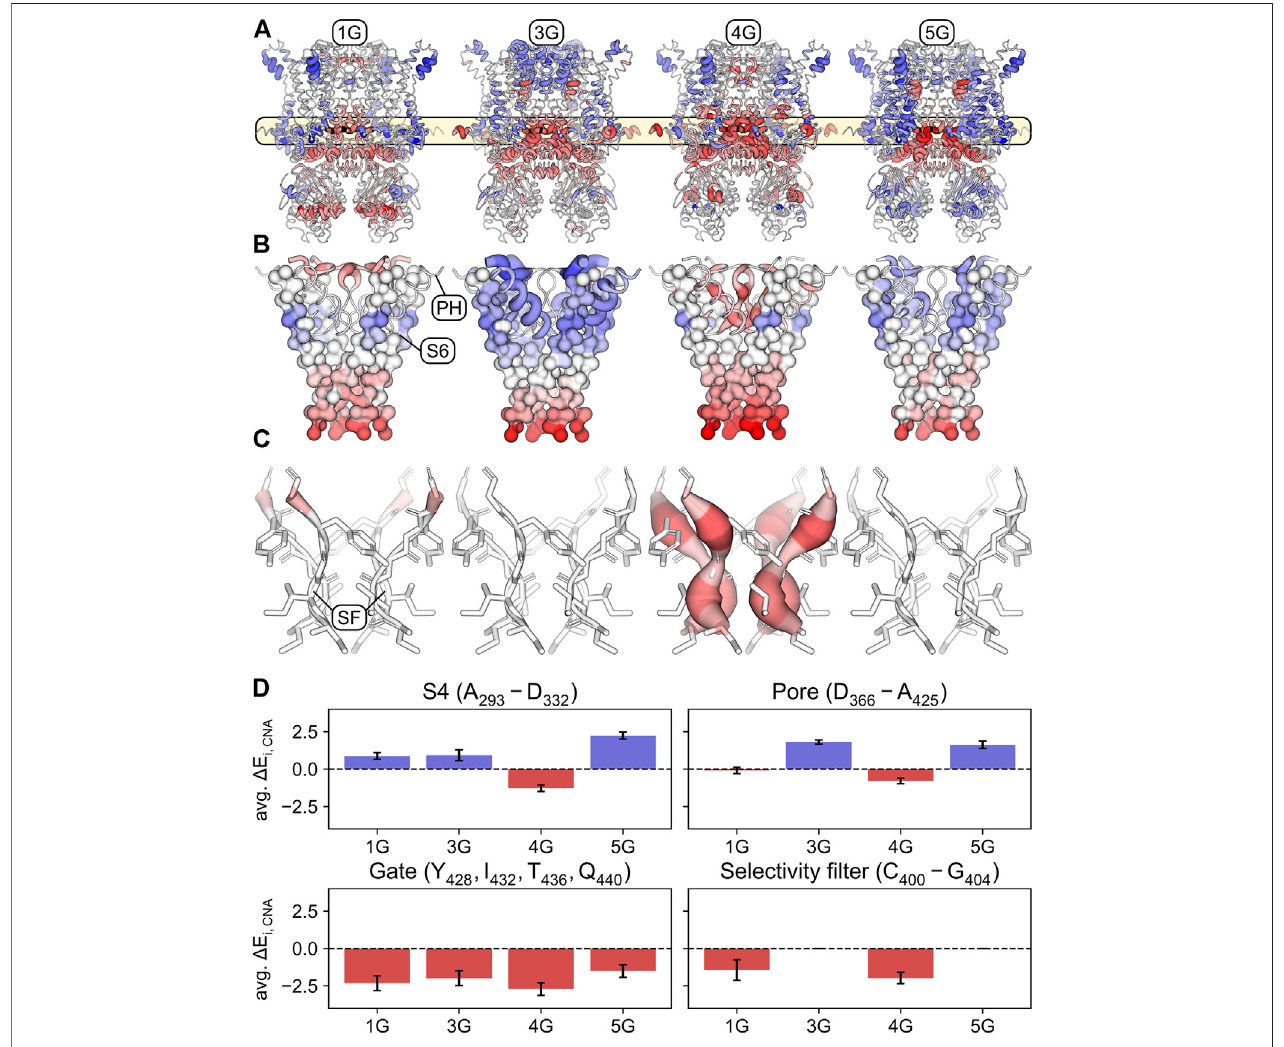
FIGURE 6 | Stabilized and destabilized regions of the glycine-linker constructs according to rigidity analyses. (A) Mapping of the differences Δ E i ,CNA = E i ,CNA(0G) − E i ,CNA( n G) – averagedacrosssimulationsandsubunits – ontothestructureofthewildtypechannel(0G).Regionsthataresigni fi cantlystabilizedintherespectiveconstruct compared to 0G (positive Δ E i ,CNA values) are shown in shades of blue. Regions that are signi fi cantly destabilized compared to 0G (negative Δ E i ,CNA values) are shown in shades of red. Shading is de fi ned by a divergent color map with Δ E i ,CNA ≤ -5.5 kcal mol − 1 : red, Δ E i ,CNA = 0 kcal mol − 1 : white, and Δ E i ,CNA ≥ 5.5 kcal mol − 1 : blue. The thickness of the cartoon representation is scaled using the absolute value | Δ E i ,CNA |. Residues for which thedifferences were not signi fi cant ( p ≥ 0.05) were assigned − 1 . (B) Similar representation as in panel Awitha focus on S6, the pore helix, and the selectivity fi lter. S6 isdepicted in a surface representation ofits Δ E i ,CNA = 0 kcal mol C-alpha trace. (C) Same representation as in panel A with a focus on the selectivity fi lter. (D) Average Δ E i ,CNA over the S4 (top left), the upper part of the pore (top right), the S6 gate (bottom left), and the selectivity fi lter (bottom right). Error bars indicate standard deviations.